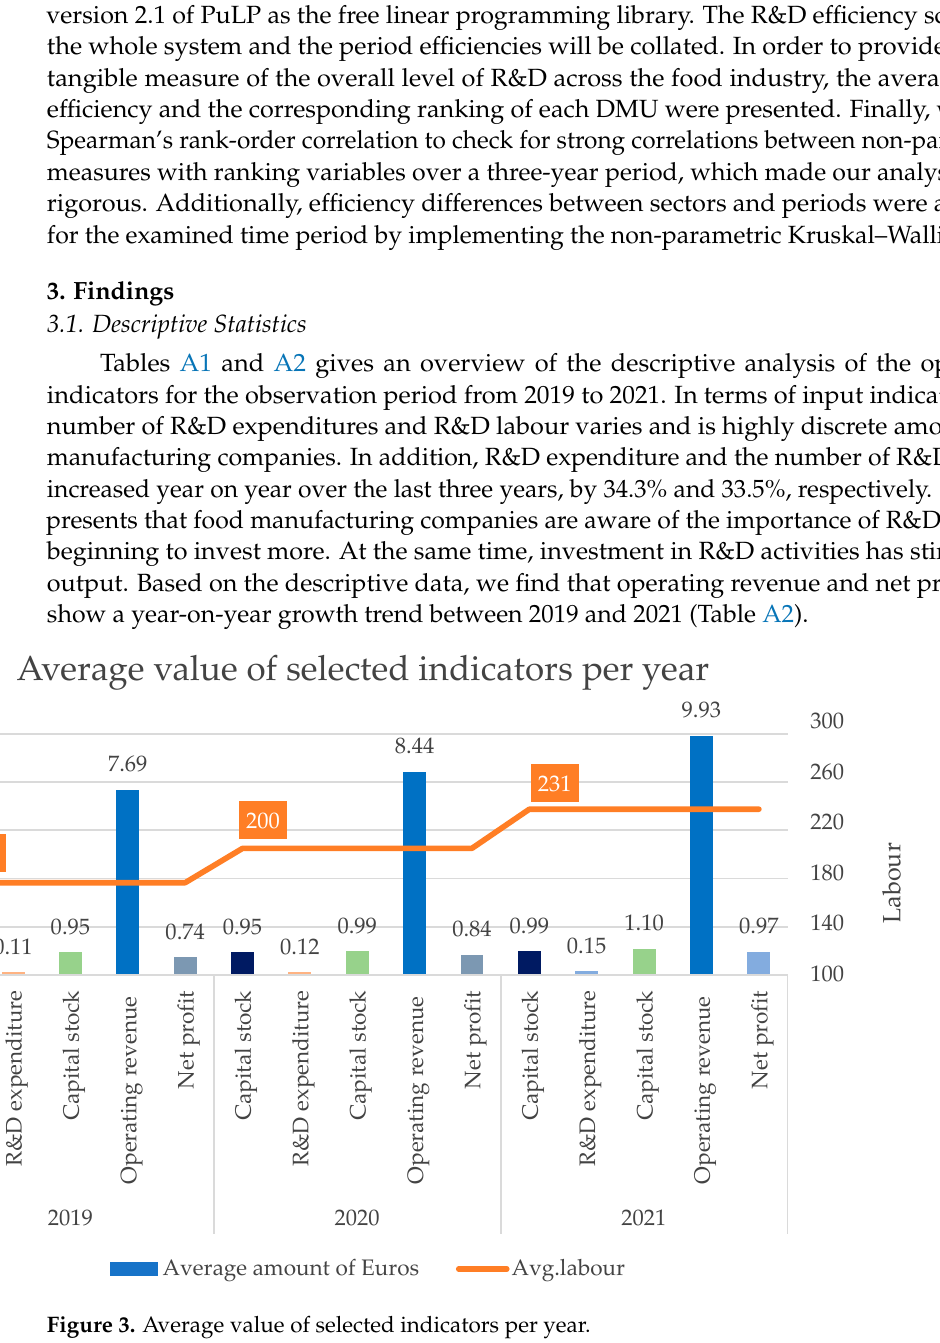
Table 5. Coefficient of correlation between inputs and outputs.